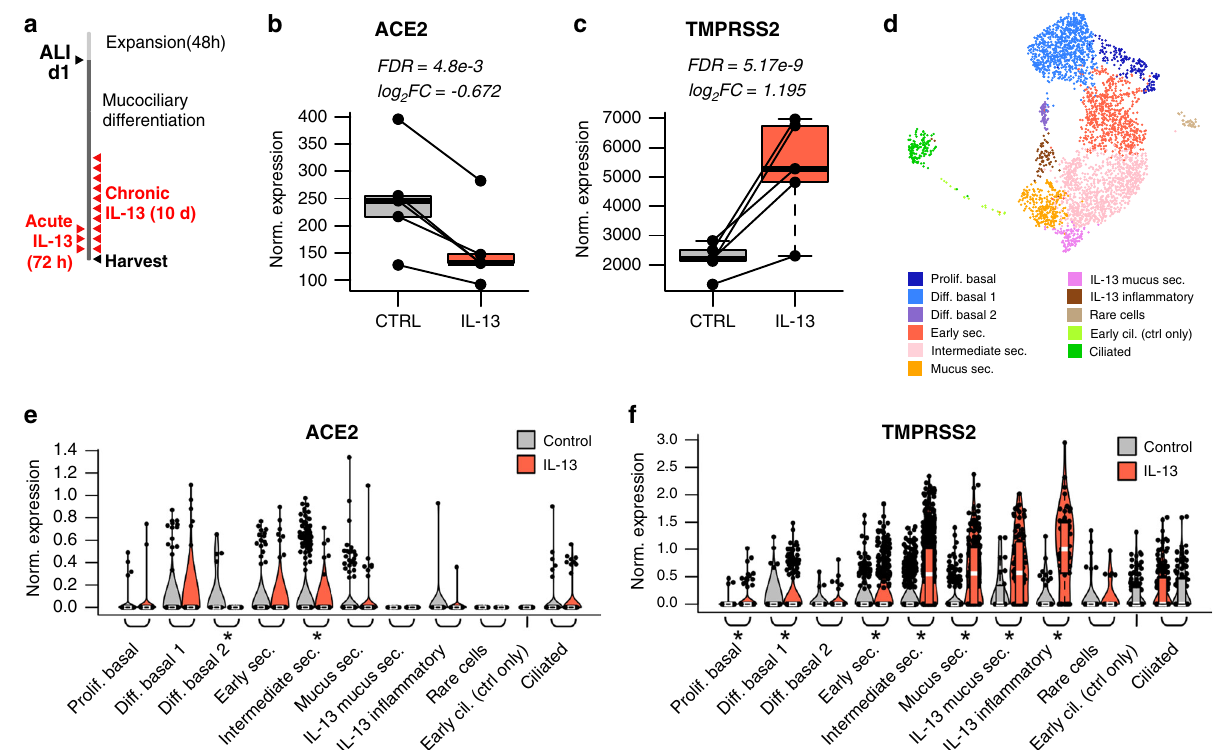
Fig. 3 ACE2 and TMPRSS2 are both regulated by IL-13 in the airway epithelium. a Experimental schematic detailing the timeline for differentiation of basal airway epithelial cells into a mucociliary airway epithelium and treatment with chronic (10 days) or acute (72 h) IL-13 (10 ng mL − 1 ). b Box plots of count-normalized expression between paired ( n = 5 pairs) nasal airway cultures (control/IL-13) revealing strong downregulation of bulk ACE2 expression with IL-13 treatment. Differential expression results are from DESeq2. Benjamini – Hochberg correction was used to control for false discovery rate. c Box plots of count-normalized expression between paired ( n = 5 pairs) nasal airway cultures (control/IL-13) revealing strong upregulation of bulk TMPRSS2 expression with IL-13 treatment. Differential expression results are from DESeq2. Benjamini – Hochberg correction was used to control for false discovery rate. d UMAP visualization of 6,969 cells derived from control and IL-13 stimulated tracheal airway ALI cultures depict multiple epithelial cell types identi fi ed through unsupervised clustering. e Violin plots of normalized ACE2 expression across epithelial cell types from tracheal airway ALI cultures, strati fi ed by treatment (gray = control, red = IL-13). Differential expression using a two-sided Wilcoxon test was performed between control and IL-13- stimulated cells with signi fi cant differences in expression for a cell type indicated by a * ( p < 0.05). p -values (left to right) = 0.62; 0.18; 2.8e − 4; 0.66; 4.6e